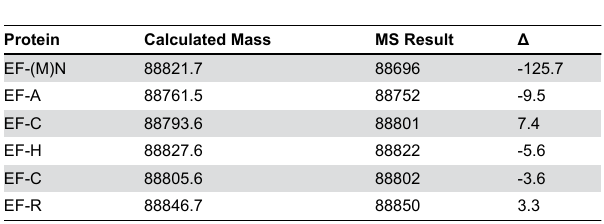
Proteins have the N-terminal sequences XNEHYTES, where X is the residue listed, e.g., A. The exception is EF-(M) N, which has the expected sequence of MNEHYTES, and the actual sequence of NEHYTES.